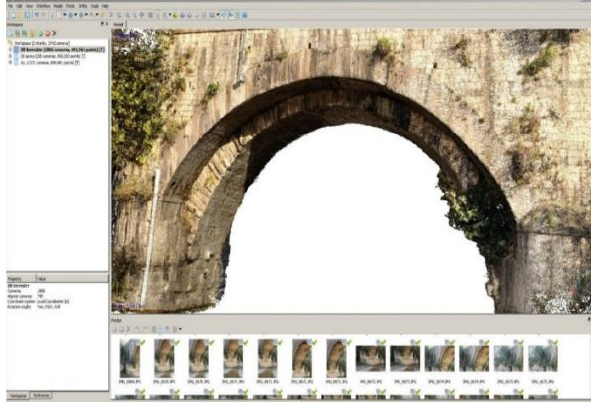
Figure 6. 3D dense point cloud representation in Photoscan